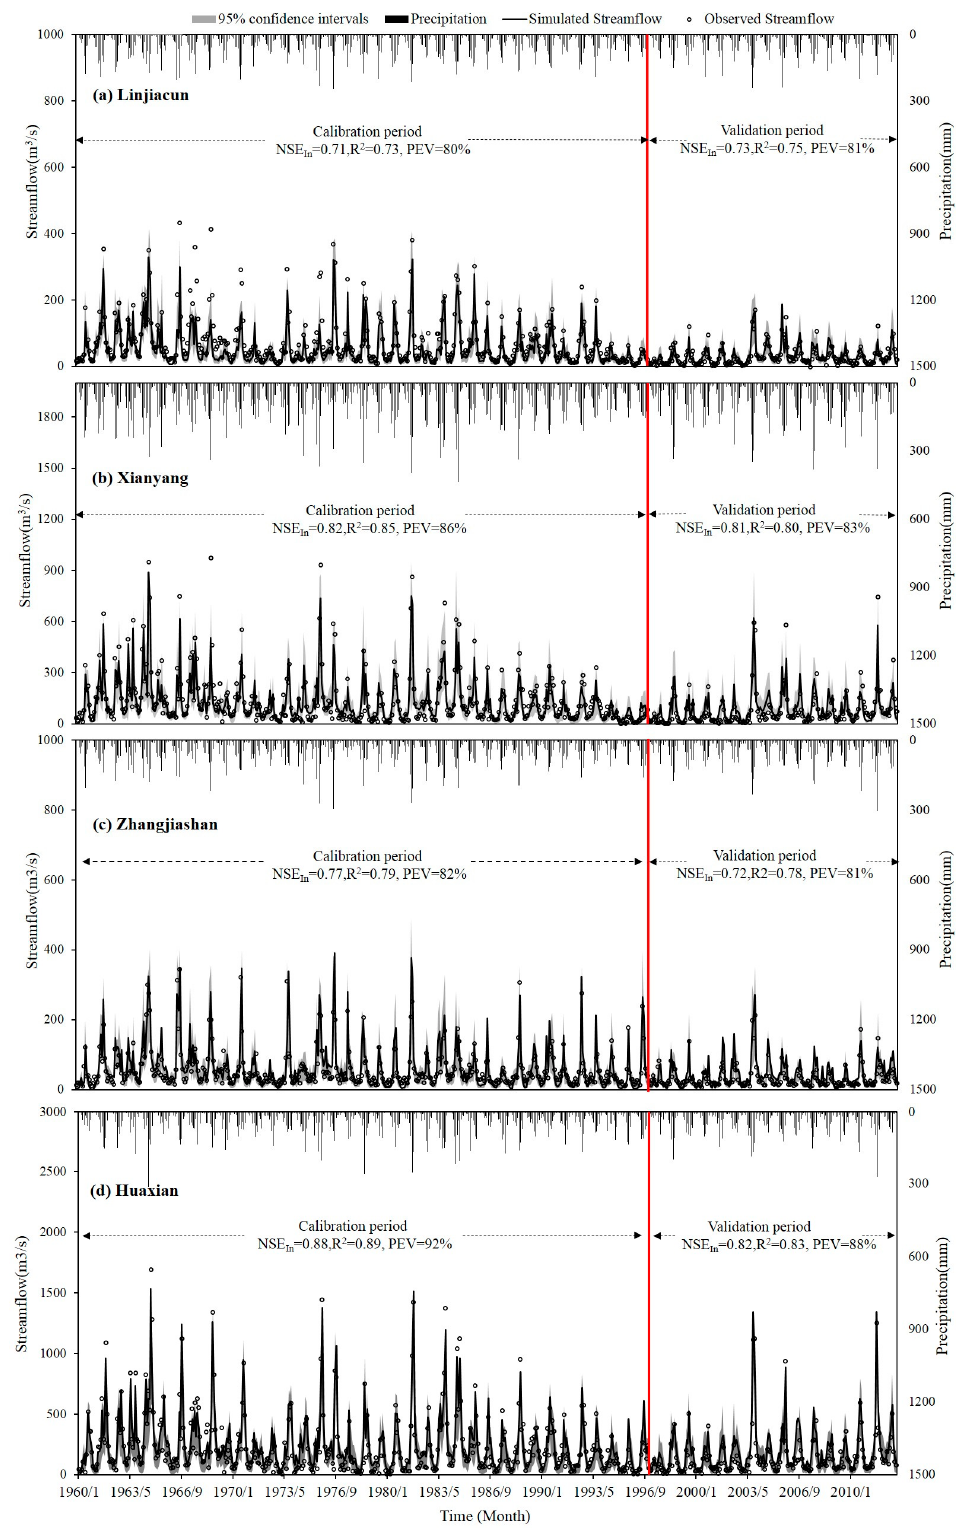
Figure 2. Comparison between the observed and simulated monthly streamflow for the four hydrological stations in WRB during the calibration and validation periods: ( a ) Linjiacun; ( b ) Xianyang; ( c ) Zhangjiashan and ( d ) Huaxian. The gray depicts the 95% confidence intervals of simulated monthly streamflow .